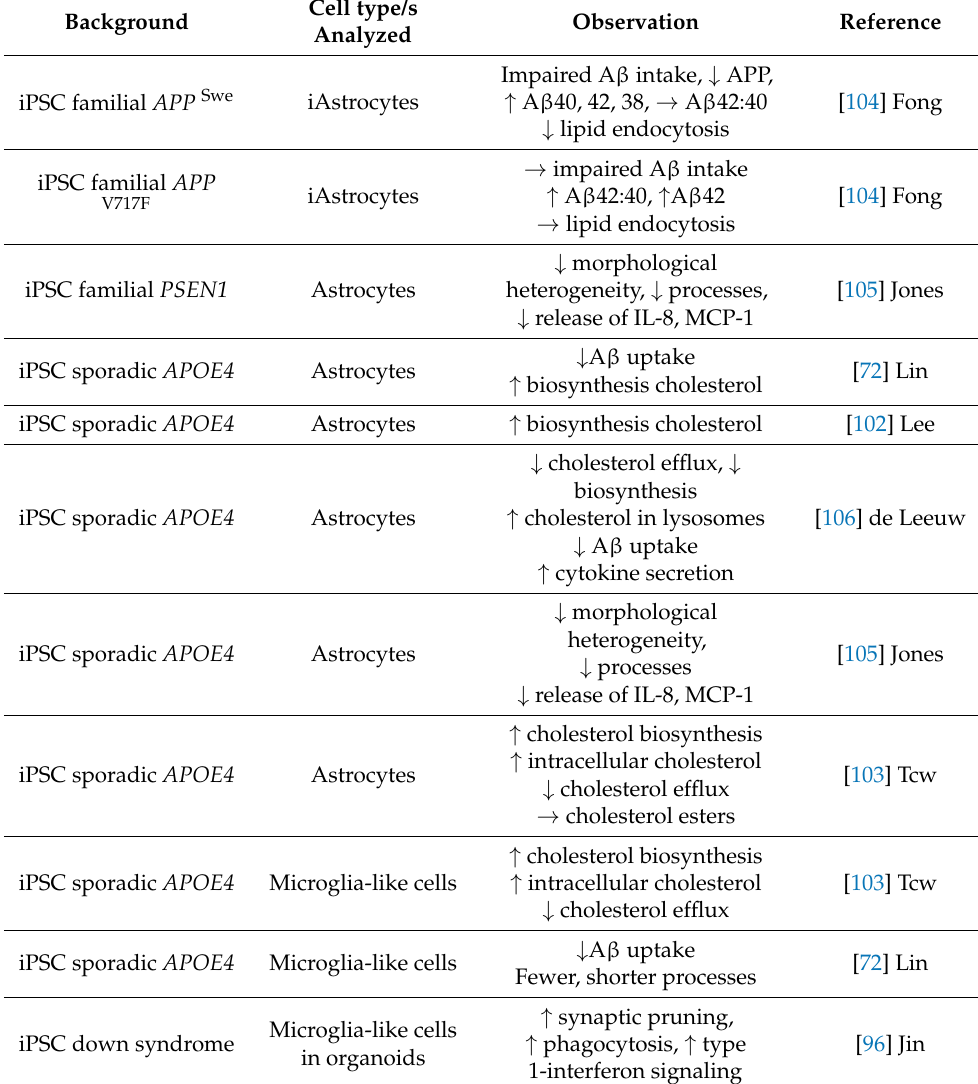
Table 5. Overview of glia dysfunction modelled in AD-iPSCs harboring either familial mutations, sporadic mutations or from late- onset sporadic AD